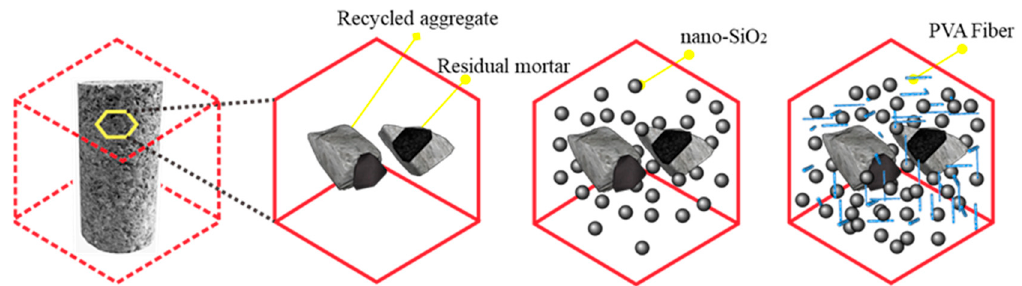
Figure 10. Synergistic mechanism of PVA fiber and NS.